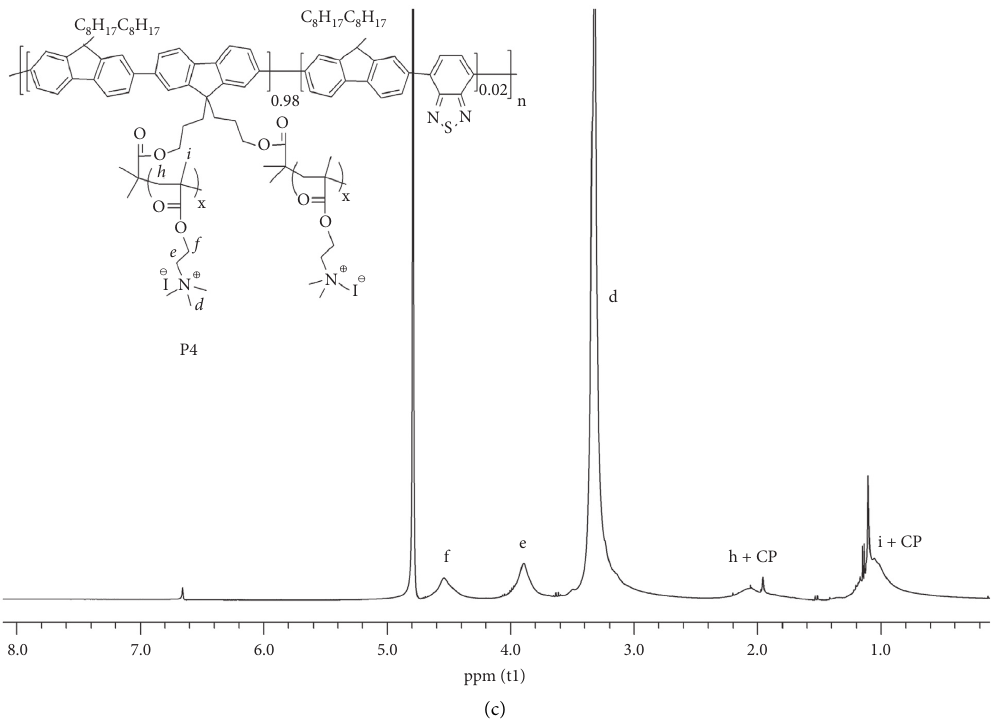
Figure 1: 1 H NMR of P3 (in CDCl 3 ), P4 (in H 2 O), and P4 ′ (in H 2 O); CP refers to alkyl chains on the fluorene